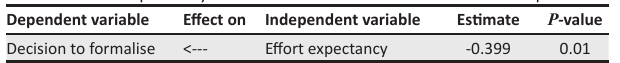
TABLE 3: Effort expectancy and decision to formalise human resource practices. Dependent